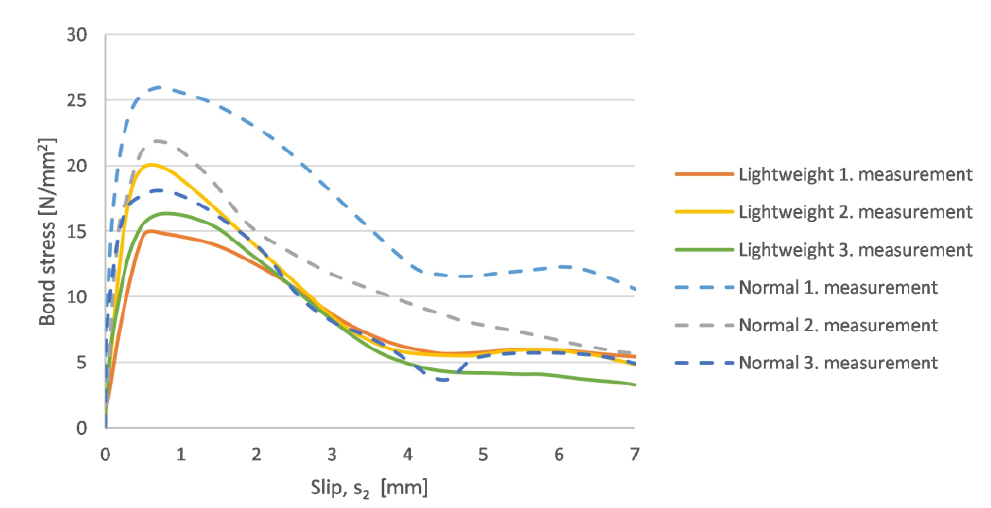
Figure 11. Bond stress–slip diagram of NWAC and LWAC.